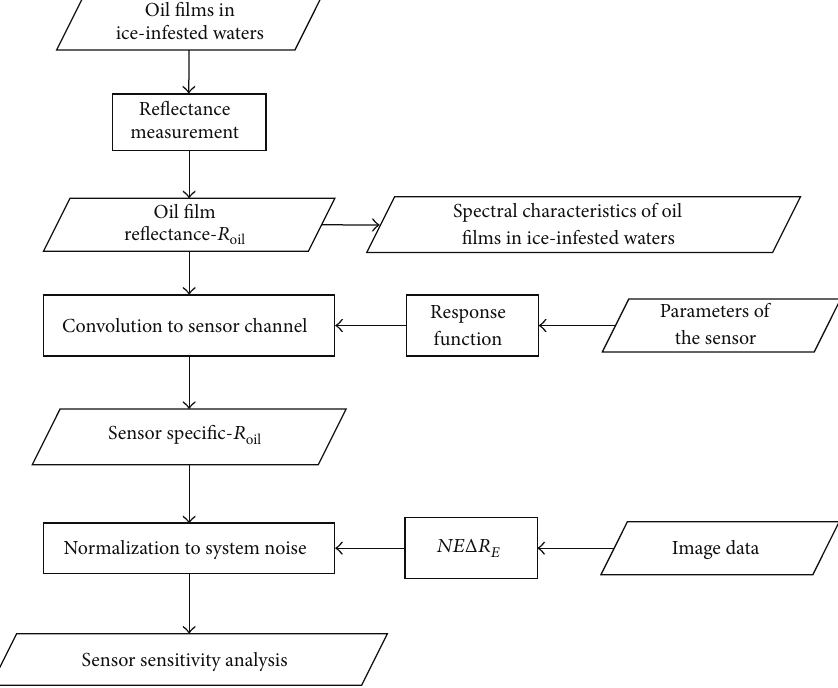
Figure 2: Flowchart of process used to conduct spectral sensitivity